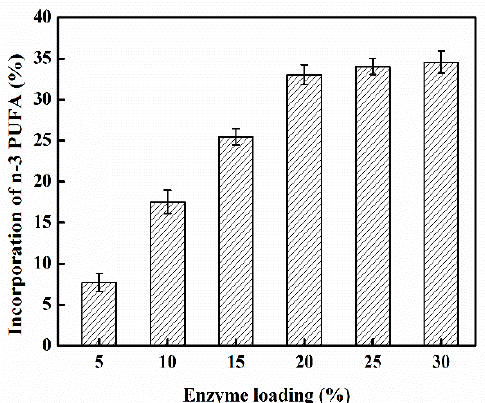
Figure 2. Effects of enzyme loading on the incorporation of n-3 PUFA into PC. Reaction conditions were as follows: n-3 PUFA-rich EE/PC mass ratio of 6:1, water dosage of 1% ( w / w ), reaction temperature of 55 °C, and reaction time of 24 h under N 2 .